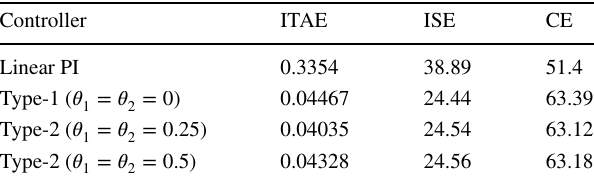
Table 8 Performance indices for set-point response (DCM) Controller ITAE